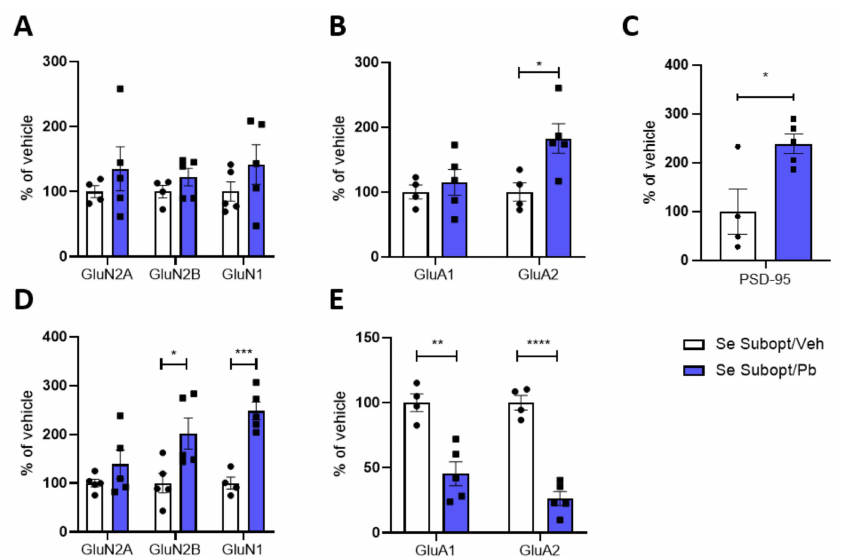
Figure 8. Effect of suboptimal Se diet and Pb exposure on glutamatergic receptors expression and post-synaptic trafficking in male juvenile rats. Expression of NMDA and AMPA receptors and PSD-95 in the homogenate ( A – C ) and TIF ( D , E ) of PND 23 hippocampi of male rats fed with suboptimal Se diet and exposed to ~1.25 mg/kg body weight Pb per day. Data were normalized on actin levels. Data are shown as individual value plots and are represented as % of vehicle ( n ≥ 4); Unpaired t -test, * p < 0.05, ** p < 0.01, *** p < 0.001, **** p < 0.0001. Different from males, Pb did not affect either the total expression or the spine